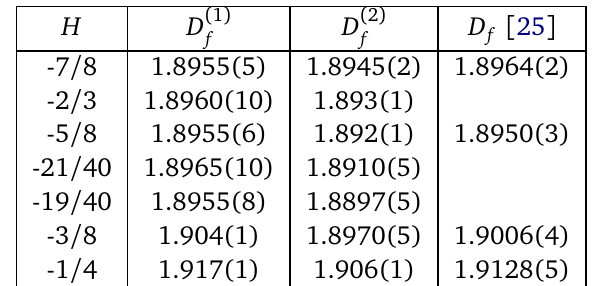
Table 12: Fractal dimensions obtained (1) from the scaling of the largest cluster (62) and (2) from the power-law decay of the two-point connectivity (11), and compari- son with previous numerical work [ 25 ]